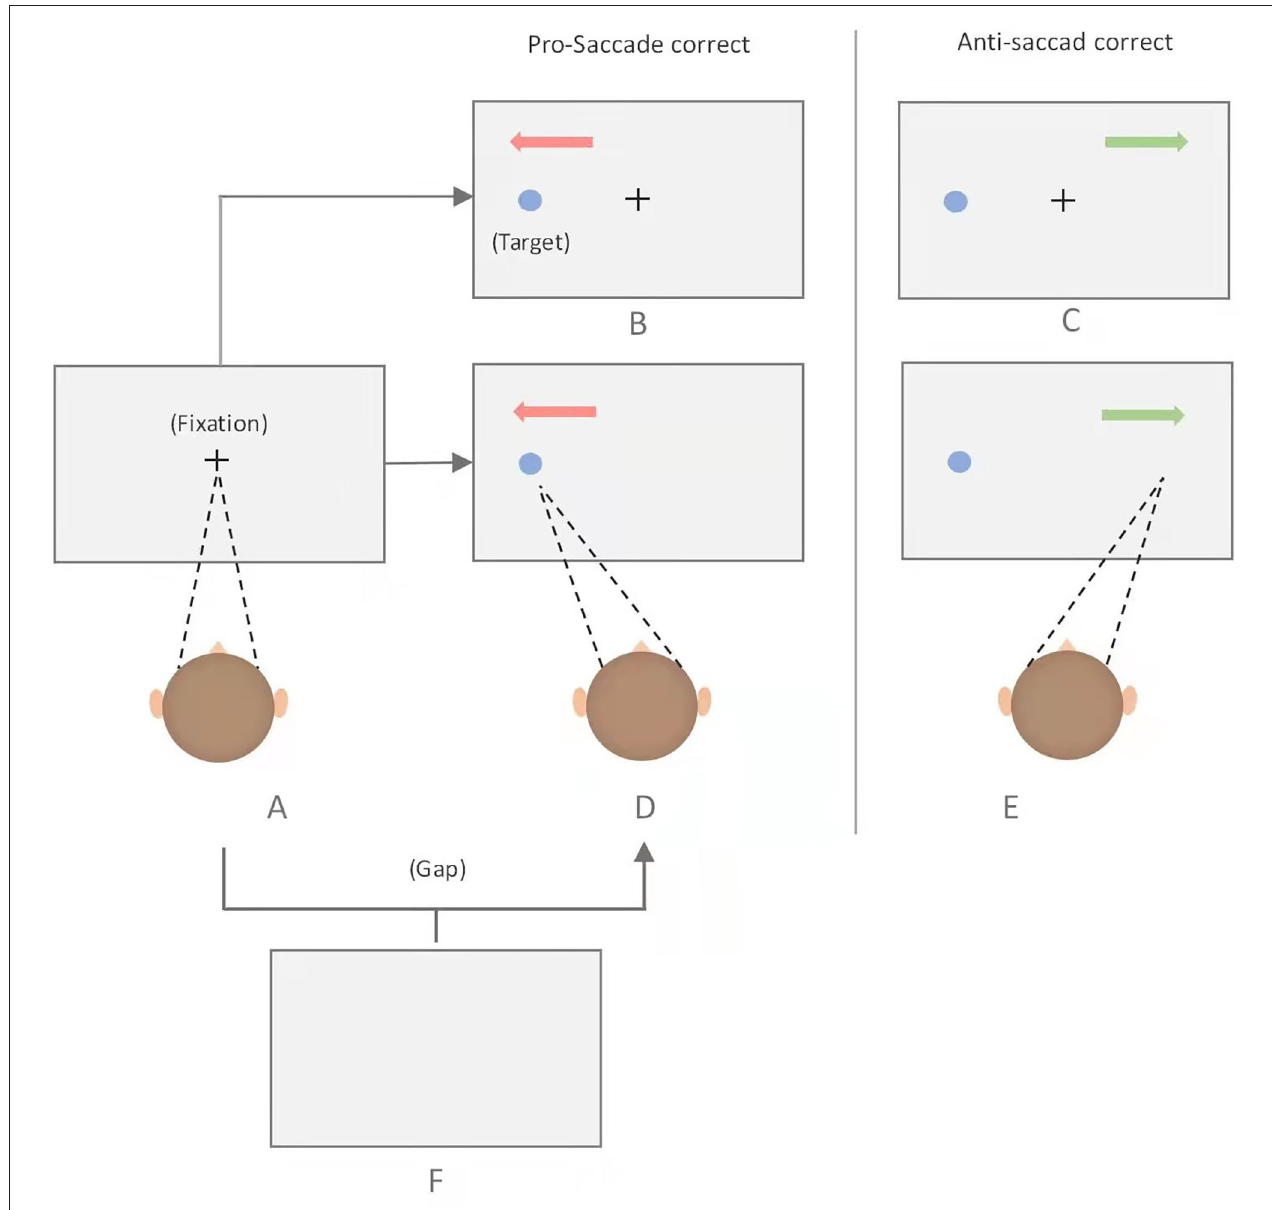
FIGURE 1 | Schematic of the pro- and anti-saccade tasks. Each trial began with the presentation of a fixation point at the center of the screen, which participants are required to fixate, and to make either a prosaccade or antisaccade depending on the task rule. Immediate pro-saccade task: A-D; Immediate anti-saccase task: A-E; Gap pro-saccade task: A-F-D; Gap ant-saccade task: A-F-E; overlap pro-saccase task: A-B; Overlap anti-saccade task: